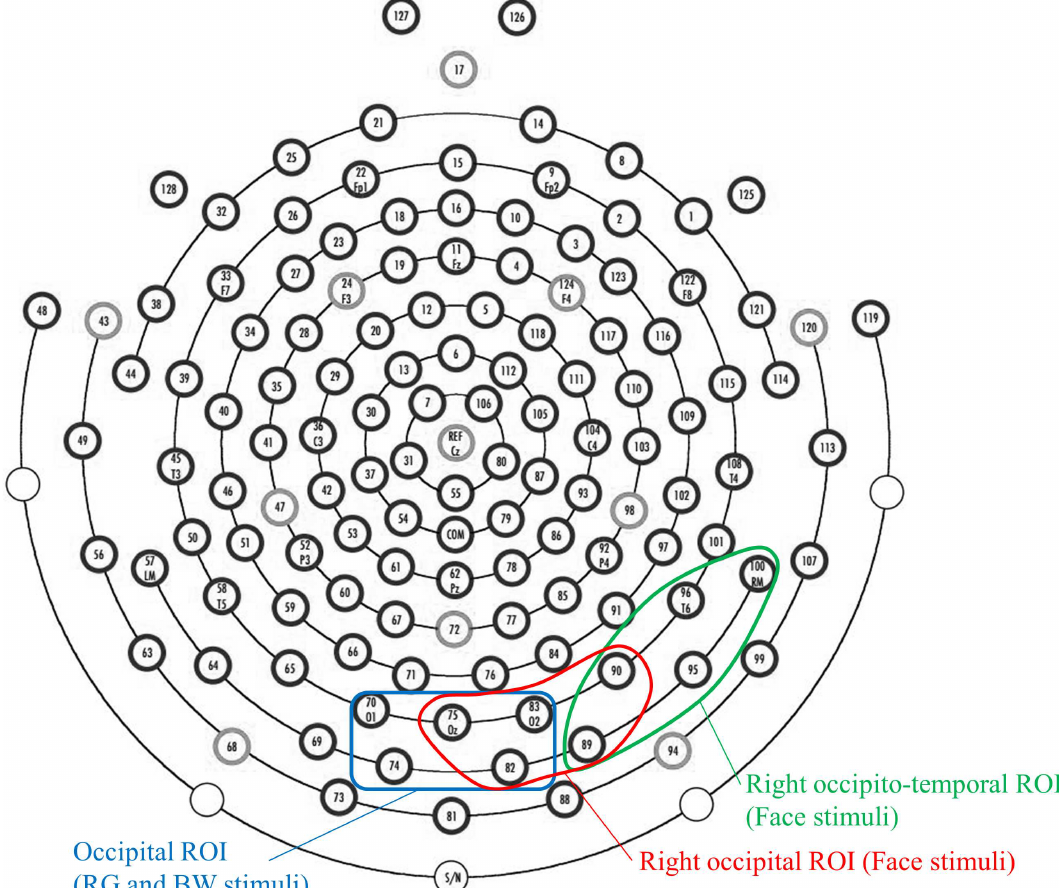
Fig 4. ROIs for each VEP measurement. We definedthree ROIs: occipitalROI for N1 in responseto RG and BW stimuli, and right occipitalROI for P1 and right occipitotemporal ROI for N170 in response to face